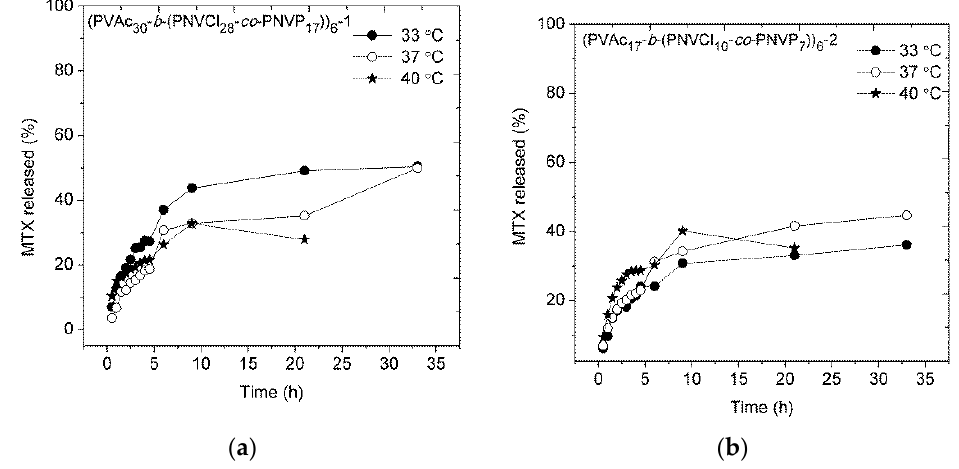
Figure 10. Drug release from micellar aggregates containing MTX: ( a ) Sample (PVAc 30 - b -(PNVCL 28 - co - PNVP 17 )) 6 ; and ( b ) Sample (PVAc 17 - b -(PNVCL 10 - co -PNVP 7 )) 6